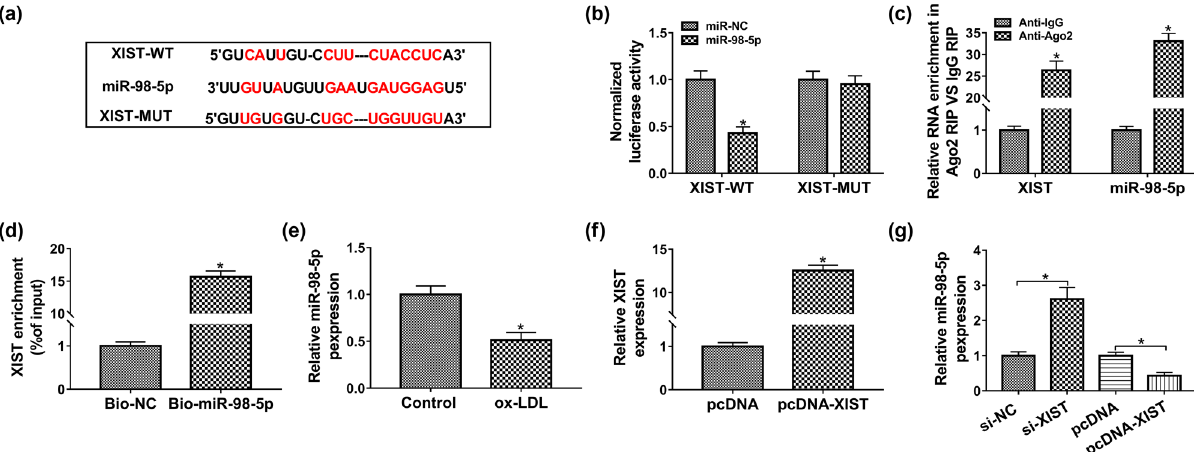
Figure 3: MiR - 98 - 5p was a direct target of XIST. ( a ) Binding region between miR - 98 - 5p and XIST was predicted by bioinformatics software. ( b ) Dual - luciferase reporter assay was performed in HUVECs to measure the luciferase activity. ( c ) After RIP assay, qPCR assay was conducted to assess the enrichments of miR - 98 - 5p and XIST in cell lysates. ( d ) RNA pull - down assay was used to con fi rm the association between miR - 98 - 5p and XIST. ( e ) The expression level of miR - 98 - 5p in HUVECs exposed to ox - LDL was determined by qPCR assay. ( f ) The transfection e ffi ciency of pcDNA - XIST in HUVECs was checked by qPCR assay. ( g ) The expression level of miR - 98 - 5p was assessed by qPCR assay in HUVECs transfected with si - NC, si - XIST, pcDNA, or pcDNA - XIST. Data shown are mean ± SD and from three independent experi - ments. * P <